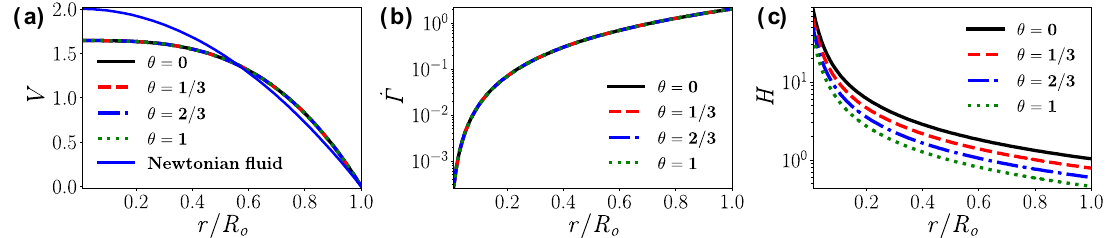
Figure 4. Dimensionless fully developed ( a ) velocity, ( b ) shear and ( c ) apparent viscosity profiles along Table 1 at the inlet are used as the reference parameters.